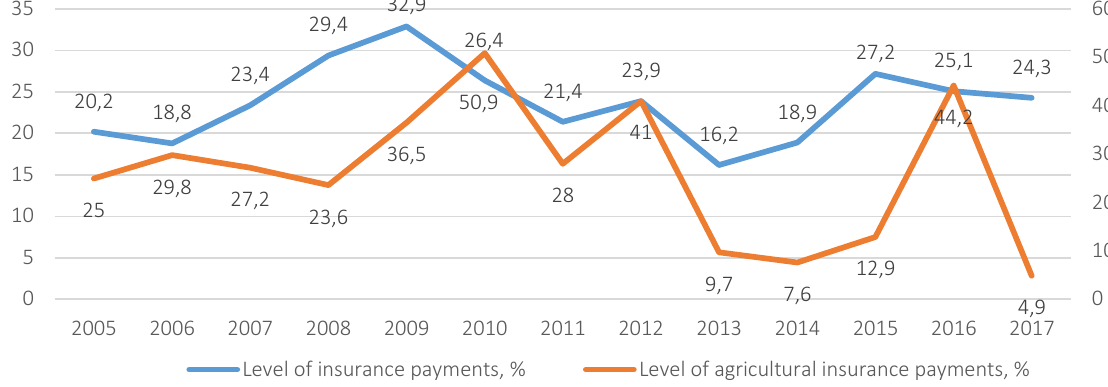
Figure 5. The level of payments*